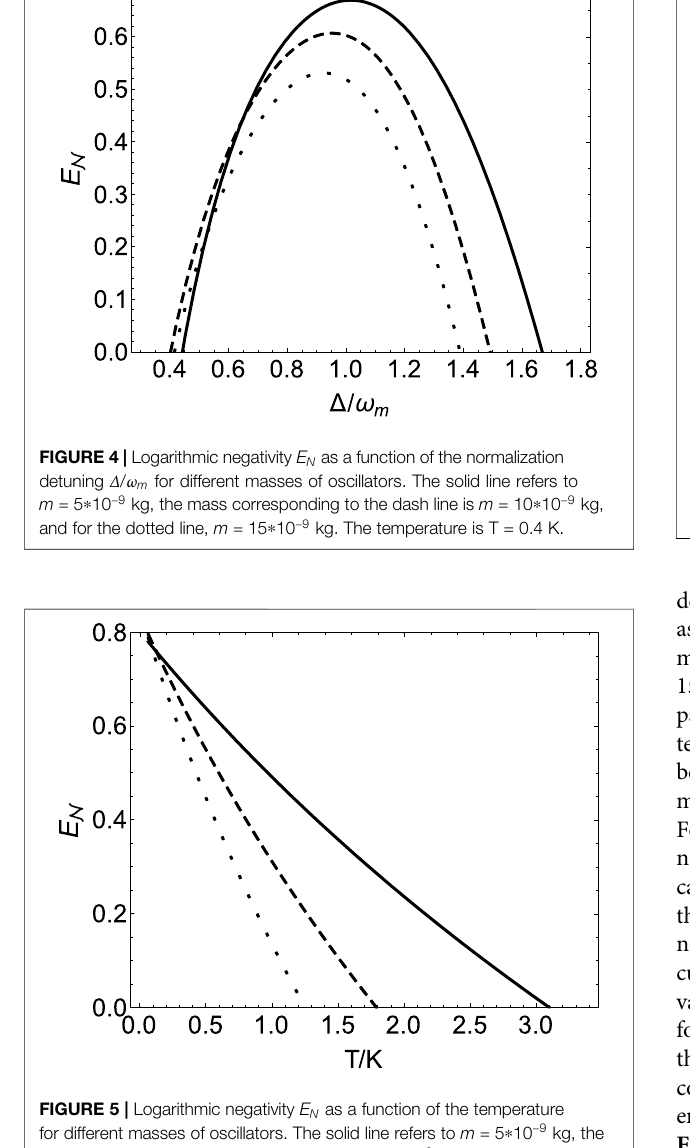
Frontiers in Physics |